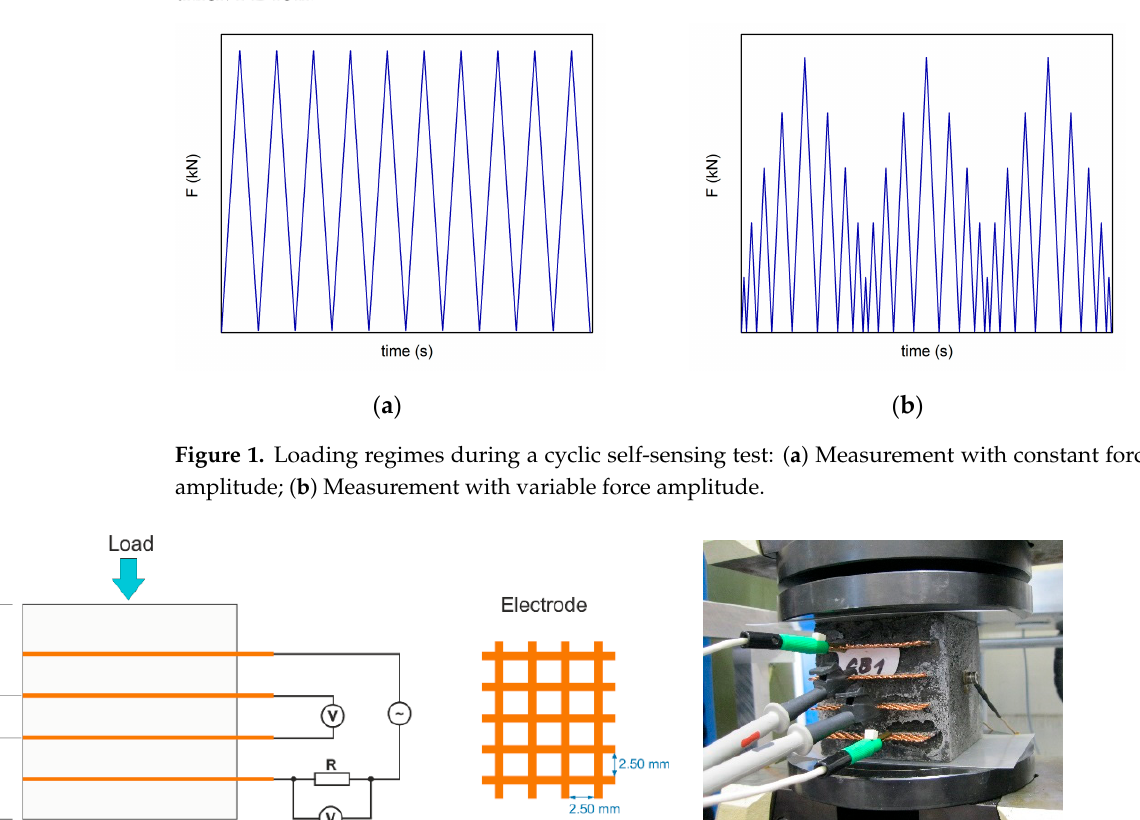
Figure 1. Loading regimes during a cyclic self-sensing test: ( a ) Measurement with constant force amplitude; ( b ) Measure- ment with variable force amplitude.